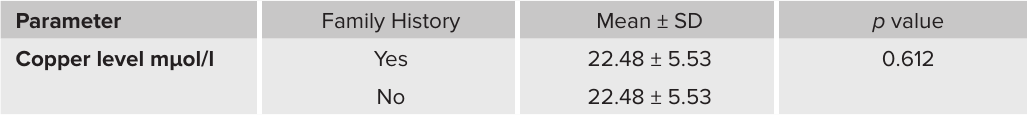
Table 4: Mean Comparison of Study Parameter across Family History.